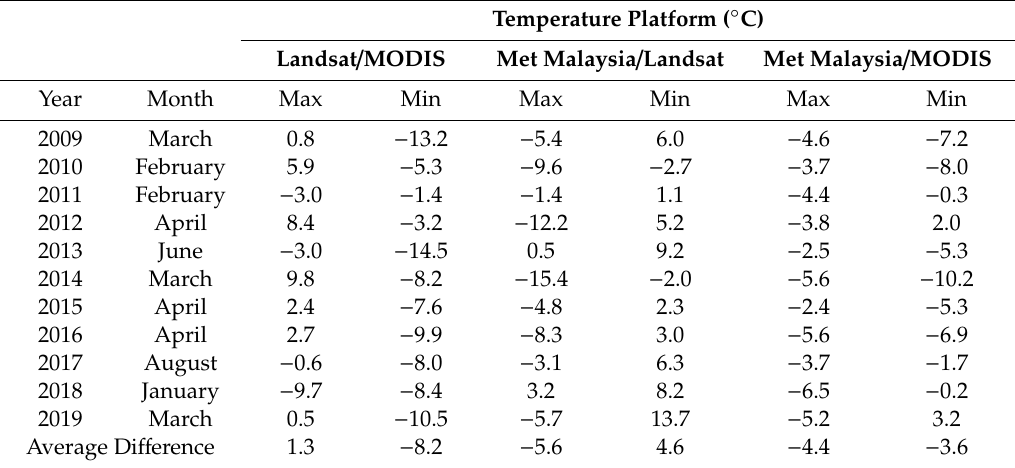
Table 10. Validation (di ff erence) estimation against recorded LST in ◦ C.